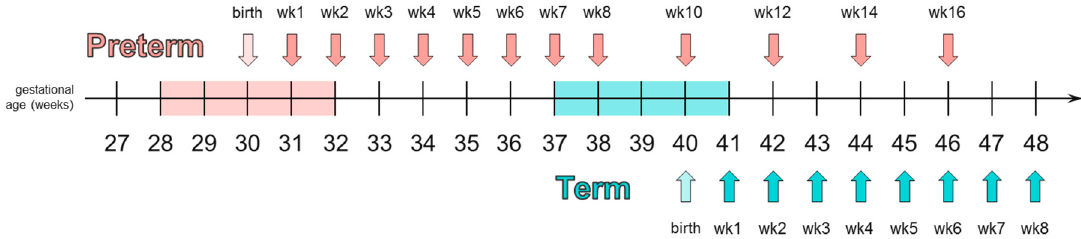
Figure 1. Example of milk sampling scheme from term and preterm mothers delivering at postmenstrual weeks 40 and 30 respectively. Reprinted from Garcia-Rodenas, et al. Clinical Nutrition, 2018 [44] with kind permission from Elsevier.